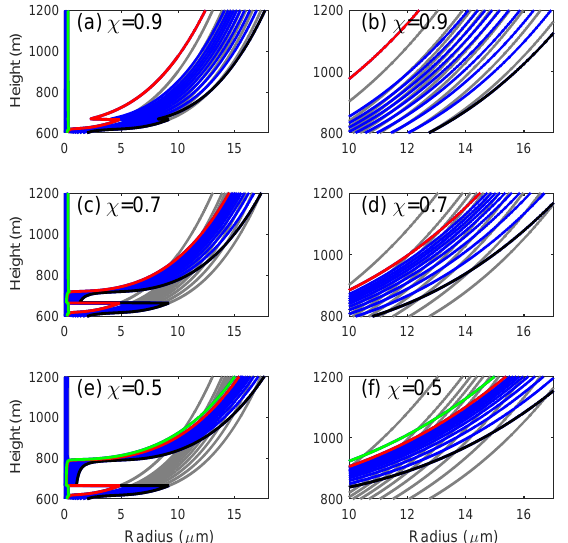
Figure 3. Radii of cloud droplets in a polydisperse population vs. height for χ = 0 . 9 , 0 . 7 , 0 . 5 in a clean environment at w = 0 . 1ms − 1 . The background grey lines represent χ = 1 . 0. The right column shows the region near the critical height where super- adiabatic growth can be expected. The black line is for the 1st bin (largest CCN), the red line for the 11th bin, and the green line for the 12th bin.